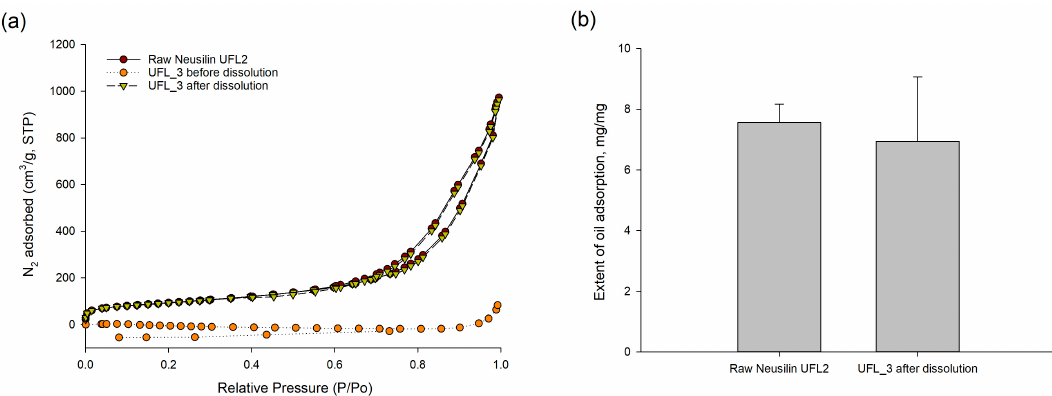
Figure 8. ( a ) Oil adsorption capacity of orlistat-loaded Neusilin ® UFL2 (UFL_3, 60% drug loading ratio) after dissolution test ( b ) and nitrogen adsorption isotherms both before and after dissolution test.